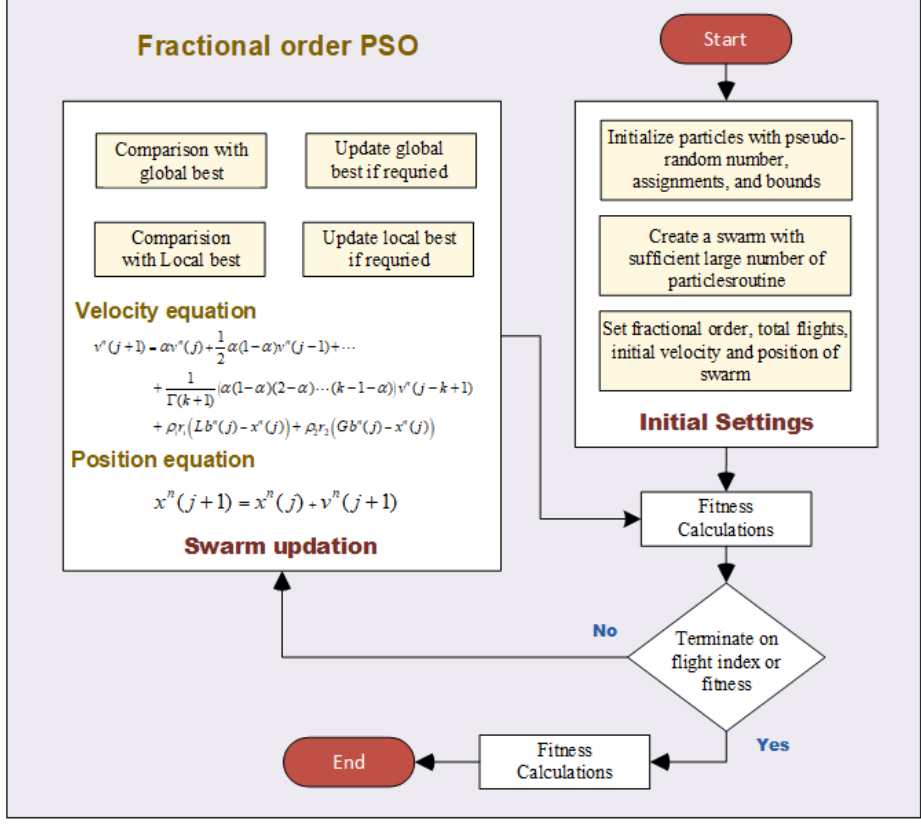
Figure 2. Process flow diagram of the FOPSO.